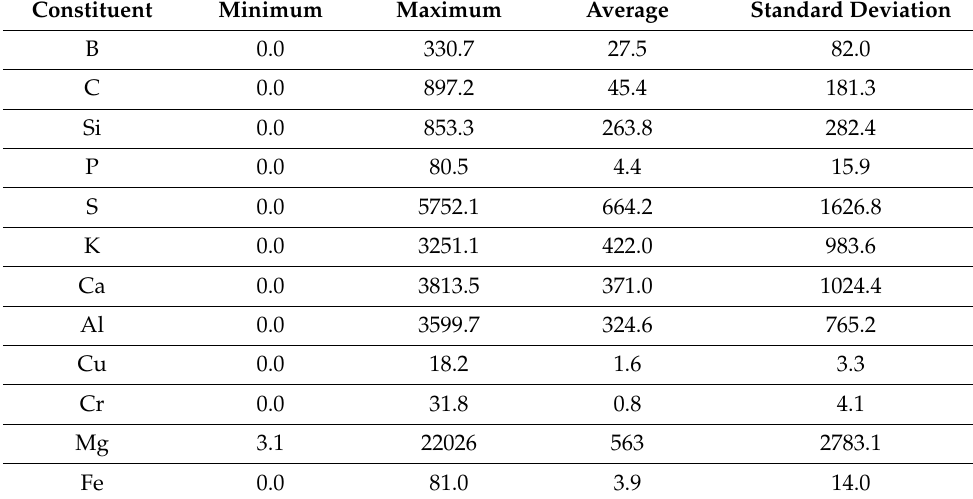
Table 1. Data parameters for digested aerosol dust results using ICP-MS analysis with concentrations in µ